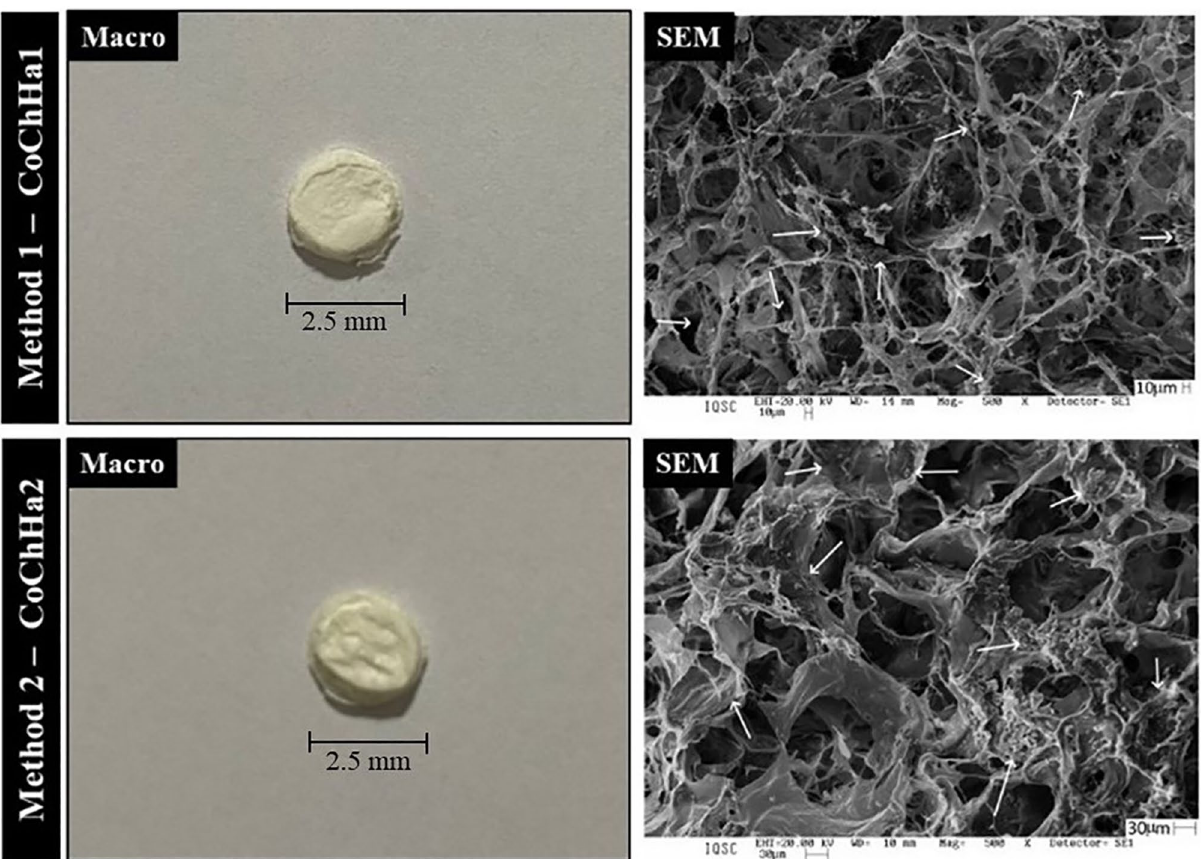
Figure 1. Macroscopic images of the scaffolds (left) and surface scanning electron photomicrographs (SEM, right) at ×500 magnification. Hydroxyapatite (arrows) was distributed throughout the polymer